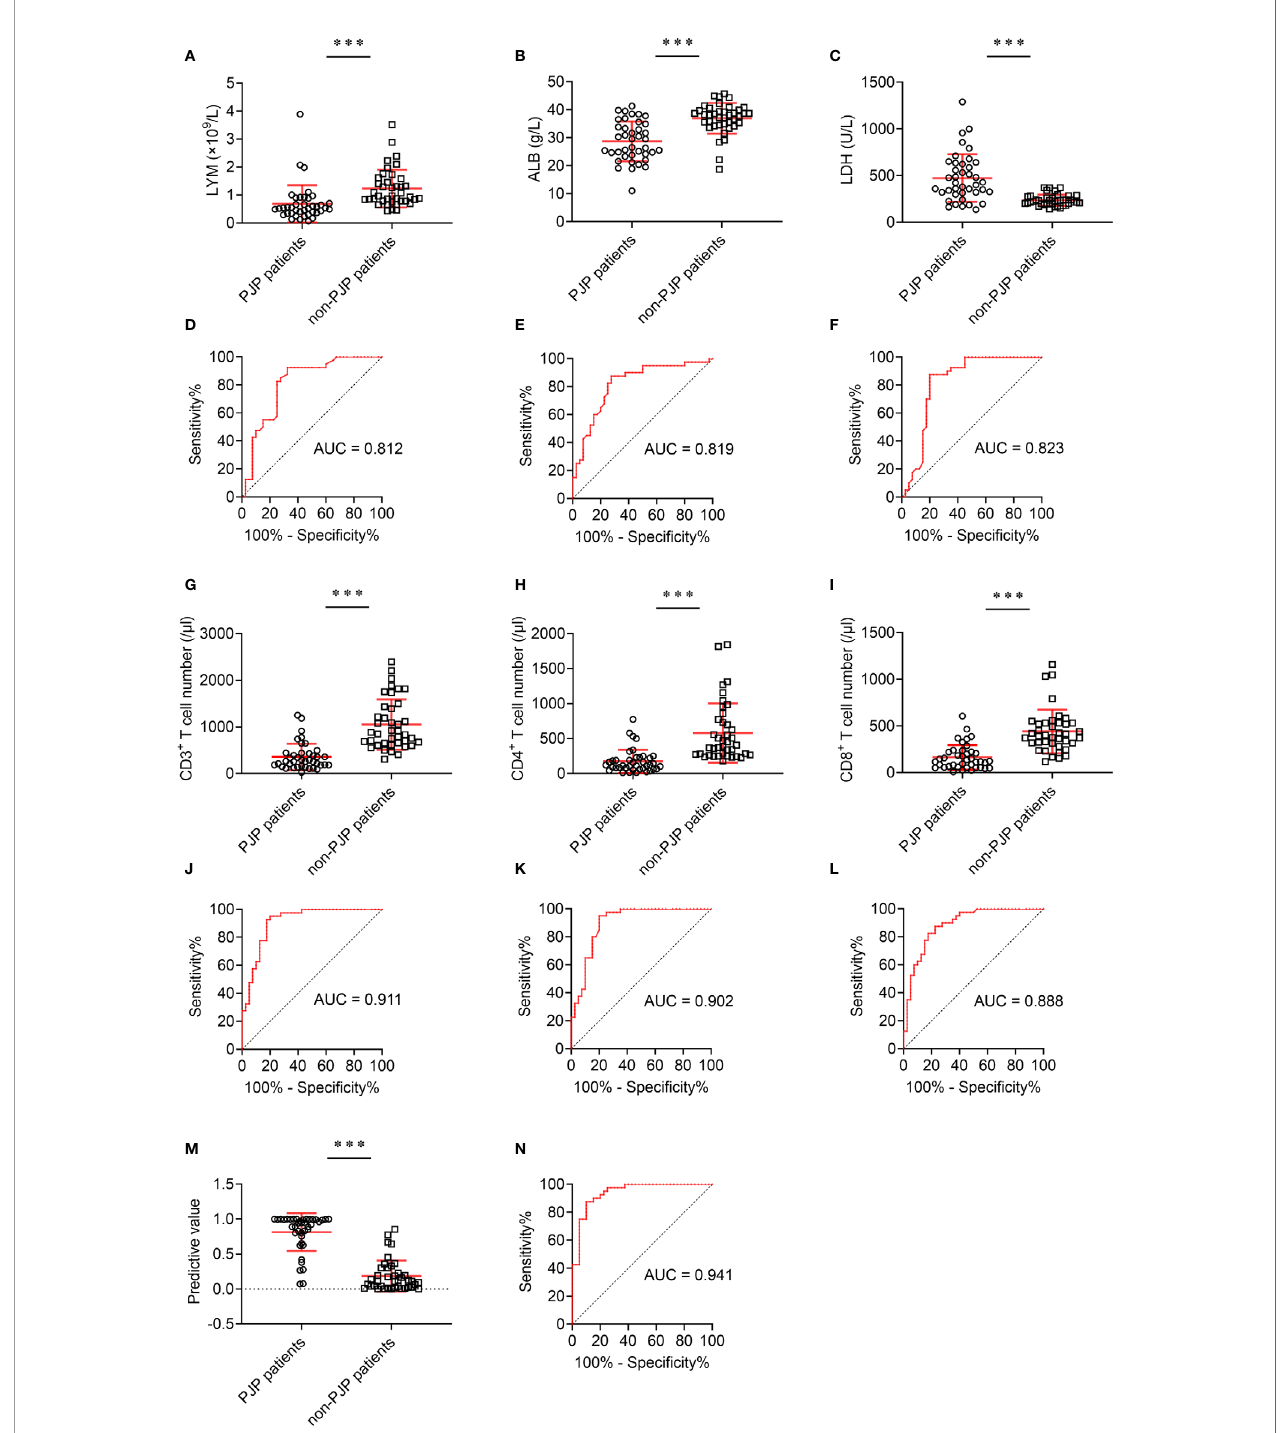
FIGURE 3 | The effect of different indicators on discriminating between PJP and non-PJP. (A) Scatter plots showing the values of LYM, (B) ALB, and (C) LDH in PJP and non-PJP patients. (D) ROC analysis showing the performance of LYM, (E) ALB, and (F) LDH in distinguishing PJP and non-PJP patients; (G) Scatter plots showing the values of CD3 + T cells, (H) CD4 + T cells, and (I) CD8 + T cells in PJP and non-PJP patients. (J) ROC analysis showing the performance of CD3 + T cells, (K) CD4 + T cells, and (L) CD8 + T cells in distinguishing PJP from non-PJP patients. (M) Scatter plots showing the value of the diagnostic model in PJP and non-PJP patients. (N) ROC analysis showing the performance of the diagnostic model in distinguishing PJP and non-PJP patients. Horizontal lines indicate the mean ± SD of each group. *** p < 0.001 (Mann-Whitney U test). LYM, lymphocytes; ALB, albumin; LDH, lactate dehydrogenase; AUC, area under the